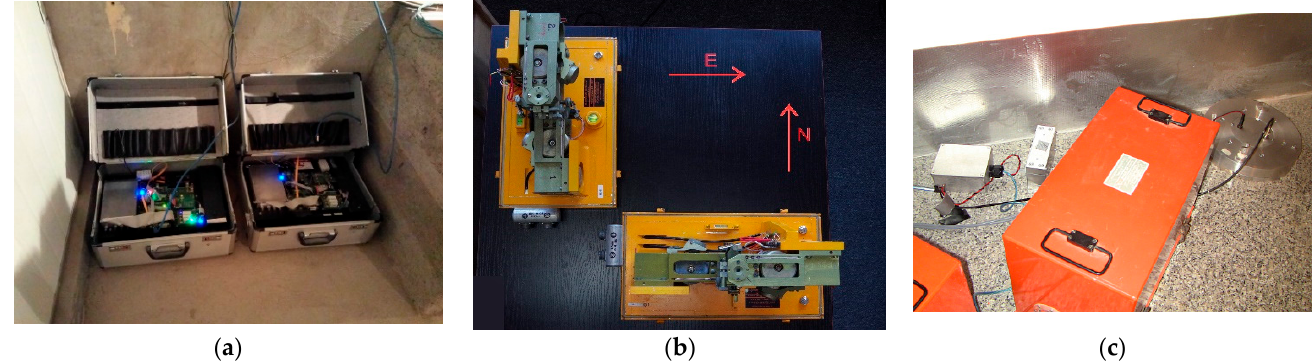
Figure 3. Photos of the rotational seismometers: ( a ) FOSREM, ( b ) TAPSs with open boxes on a table and ( c ) TAPSs (red boxes) and the CZ sensor (silver, to the right) at the location in the Ksi ąż underground.